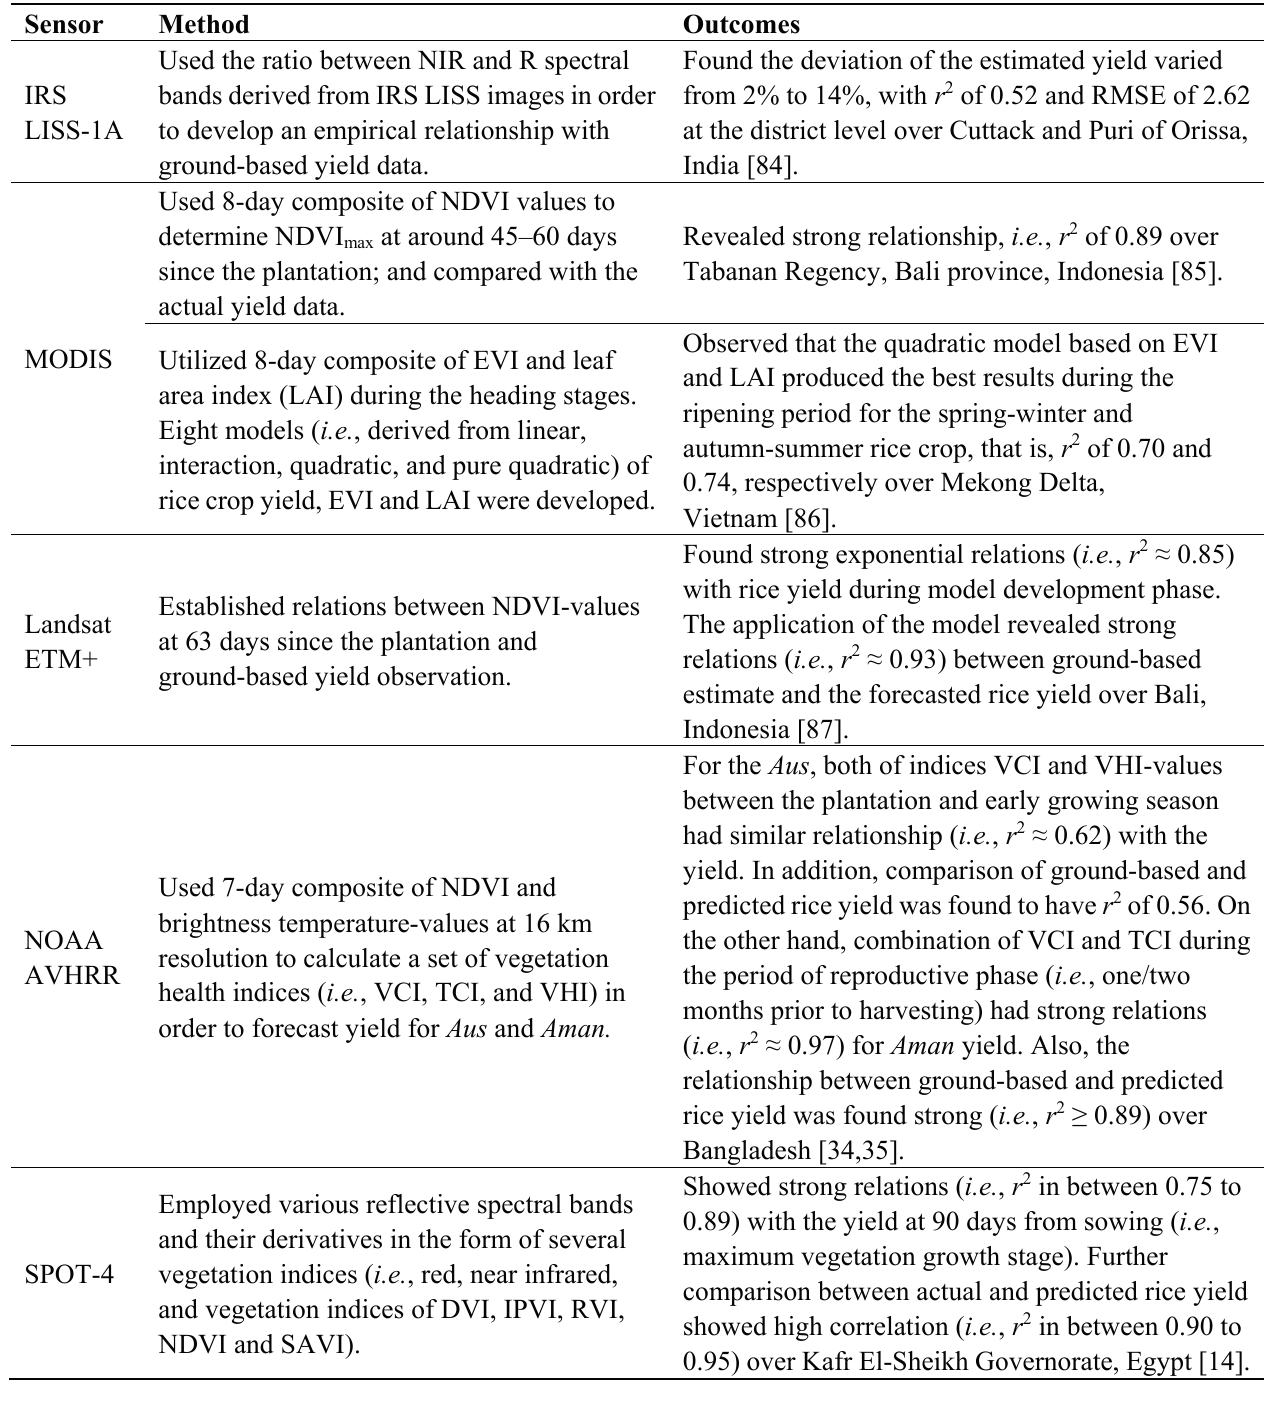
Table 5. Examples of optical remote sensing-based methods used for forecasting rice